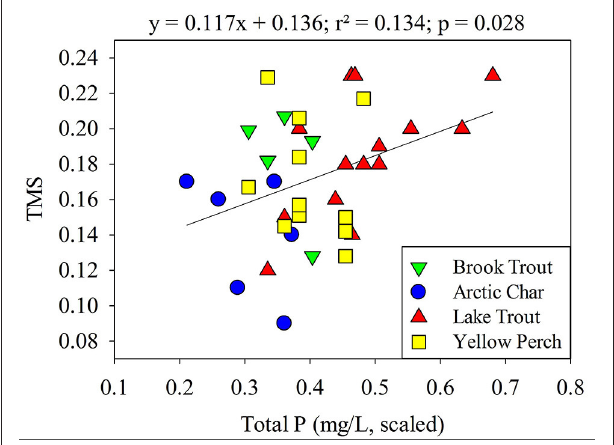
FIGURE 4 | Relationship between TMS values and scaled total phosphorous (mg/L) of lakes. Brook Trout data are from the current study whereas Yellow Perch, Arctic Char, and Lake Trout data are from Clayden et al. (2013) , Lescord et al. (2015), and Kidd et al. (2012),